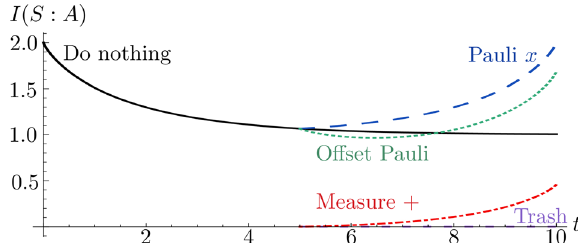
Fig. 1 Memory in shallow pocket dynamics. The mutual informa- tion I ( S : A ) between a system and auxilliary initially in a Bell pair decays exponentially as the system undergoes shallow pocket evolution (black). However, this is not the case if an intervention is applied at t 1 ( = 5 above). We depict σ x (blue); an offset rotation ffiffiffiffiffiffiffiffiffi ffiffiffiffiffiffiffiffiffi p p σ σ 0 : 05 0 : 95 x þ z (green); measurement of and trash-and-reprepare (purple).